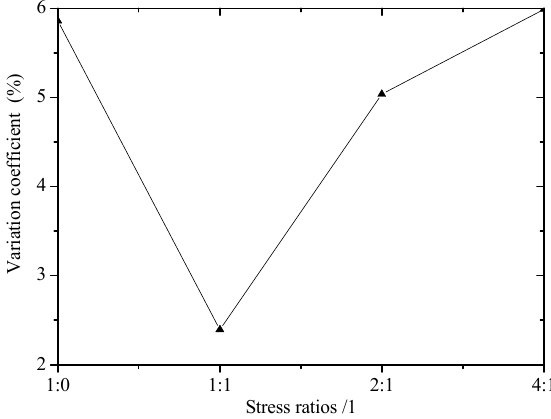
Figure 10. E ff ect of stress ratios on stress in central Figure 10. Effect of stress ratios on stress in central region.